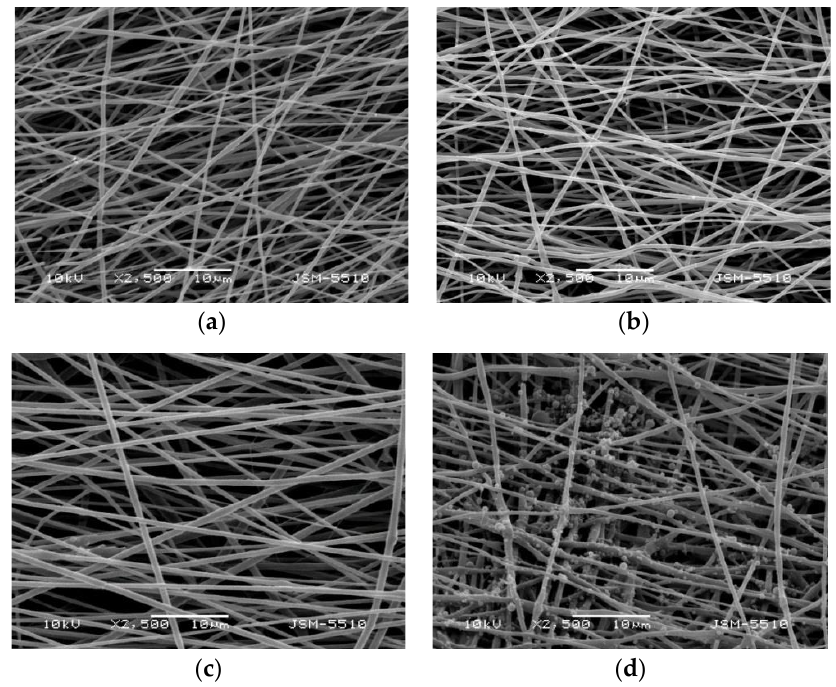
Figure 2. SEM micrographs of the fibers of: ( a ) PVP in PHB; ( b ) PVP,CQ in PHB; ( c ) PHB; and ( d ) PVP,CQ on PHB. Magnification ×2500. ( d ) PVP,CQ on PHB. Magnification ×